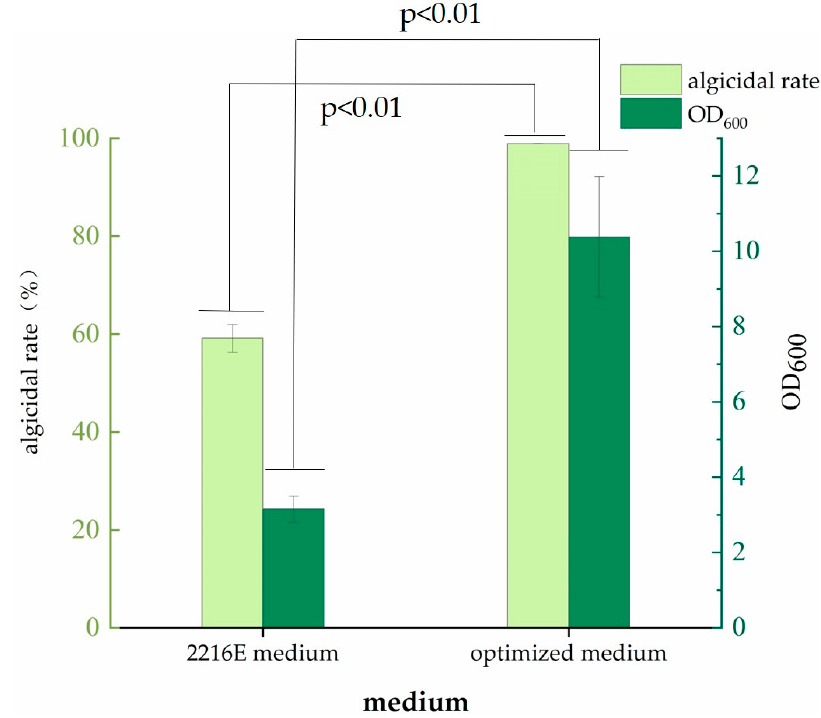
Figure 5. Algicidal rate of strain FDHY-03 against P. donghaiense and bacterial density in 2216E medium and optimized medium. Error bars represent the standard deviation of the triplicates.